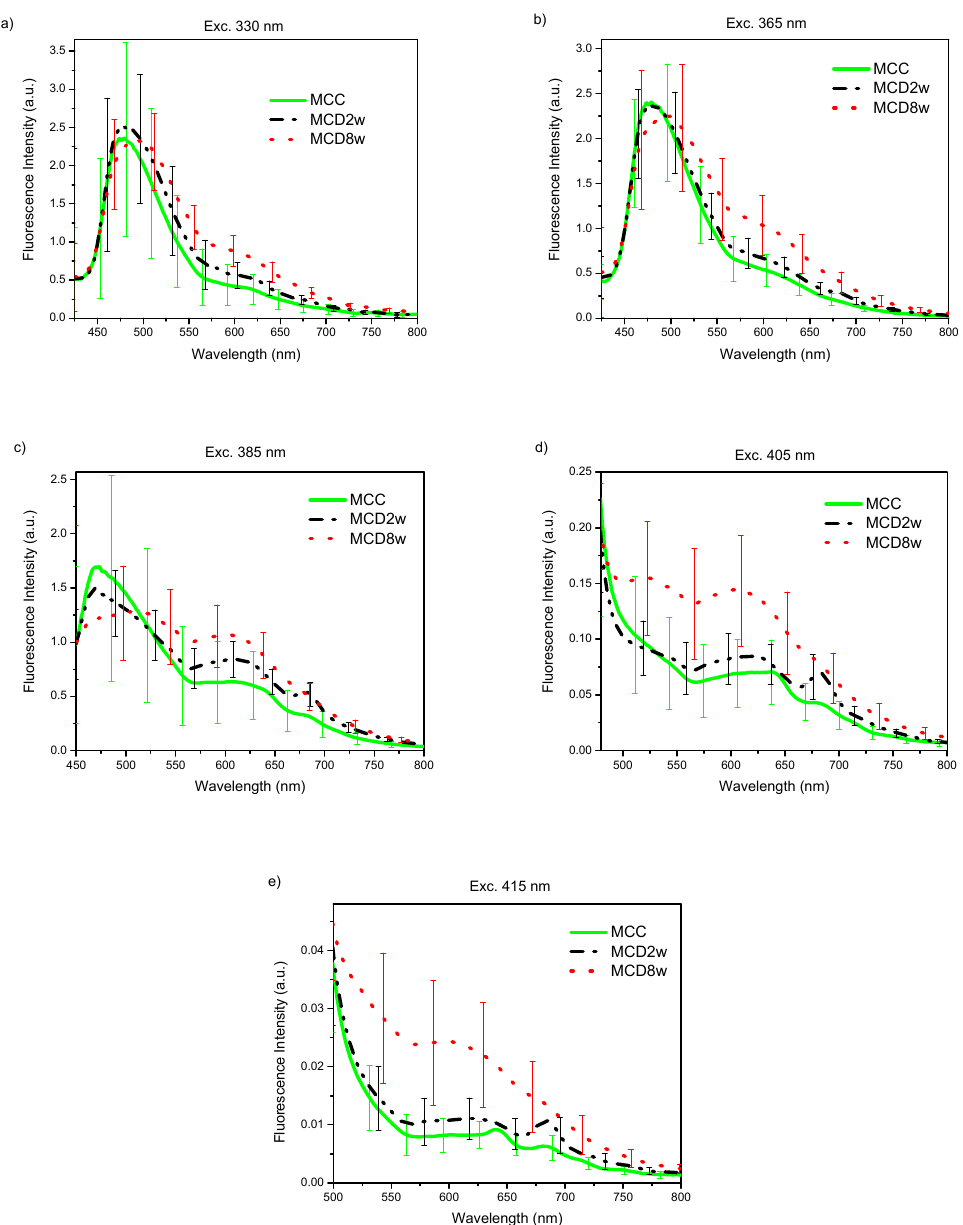
Figure 1. Endogenous fluorescence spectra from control (MCC), and steatosis (MCD2w, and MCD8w) groups, after the spectral sensitivity correction, at excitation wavelengths of ( a ) 330, ( b ) 365 nm, ( c ) 385 nm, ( d ) 405 nm, and ( e ) 415 nm. The spectra are presented as mean ± standard deviation of all gathered spectral observations.